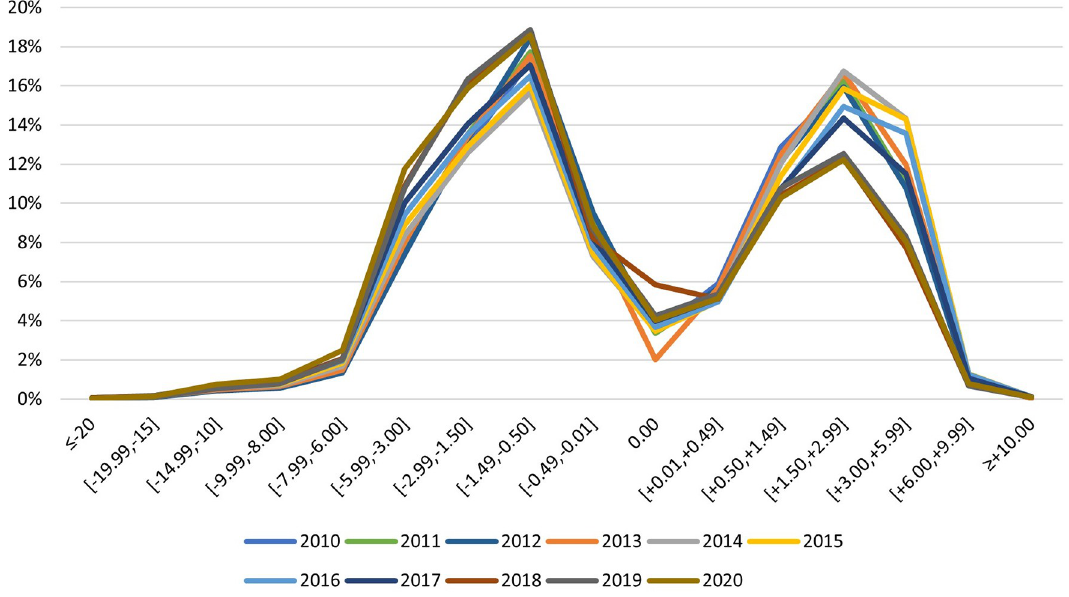
Fig 1. Distribution of ophthalmic prescriptions in Portugal from 2010 to 2020—single